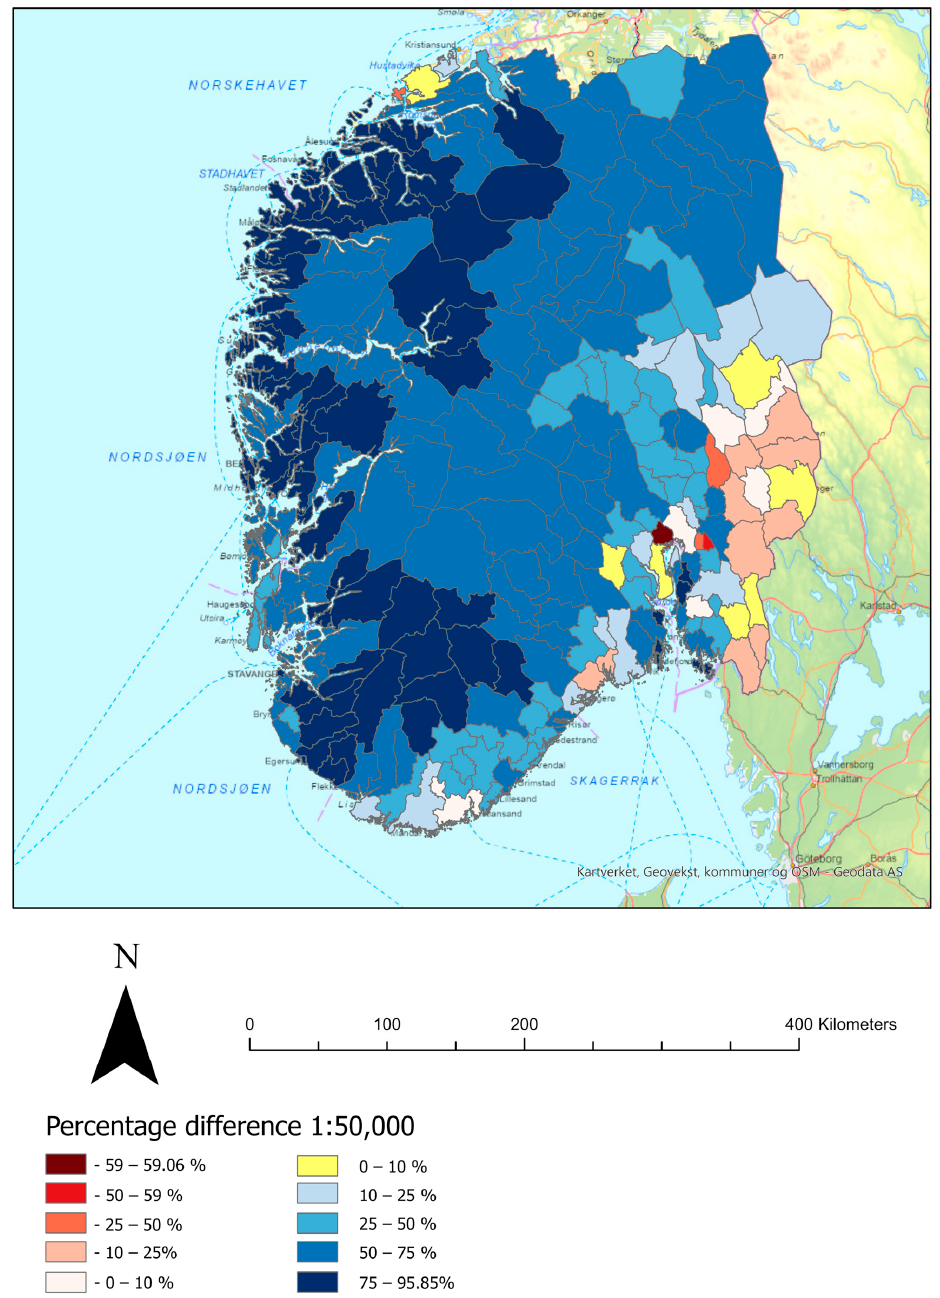
Figure 5. Visualization of the differences in predicted wetland coverage and existing reference data at the scale of